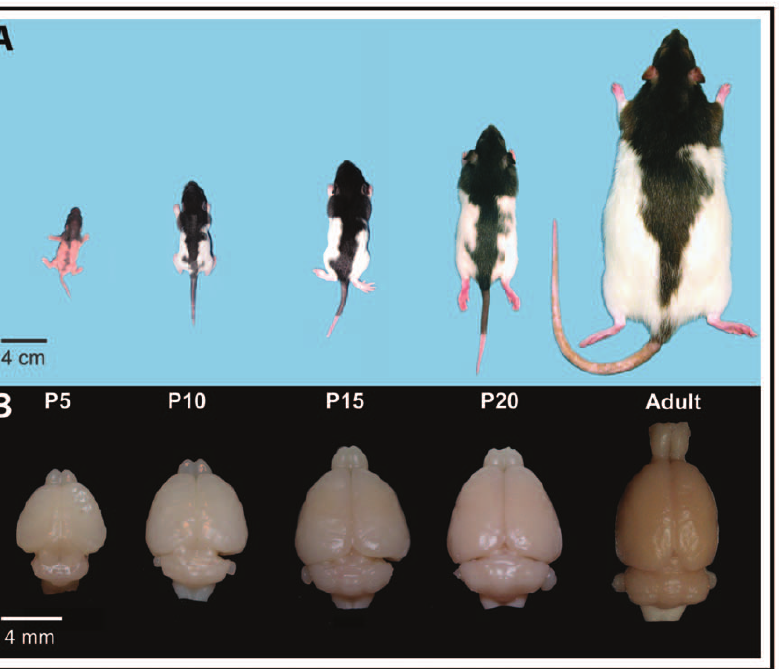
Figure 2. Changes in brain and body size across development. A) Scaled pictures of Long Evans rats at P5, P10, P15, P20, and during adulthood. B) The relative sizes of the rat brains at the same ages. While both the size and shape of the body change dramatically across development, the size and shape of the brain changes less significantly than the body.